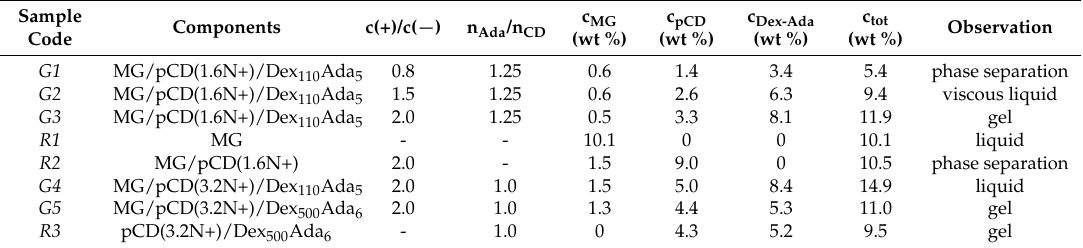
Table 2. Molar ratios and weight concentrations of the components in supramolecular gel